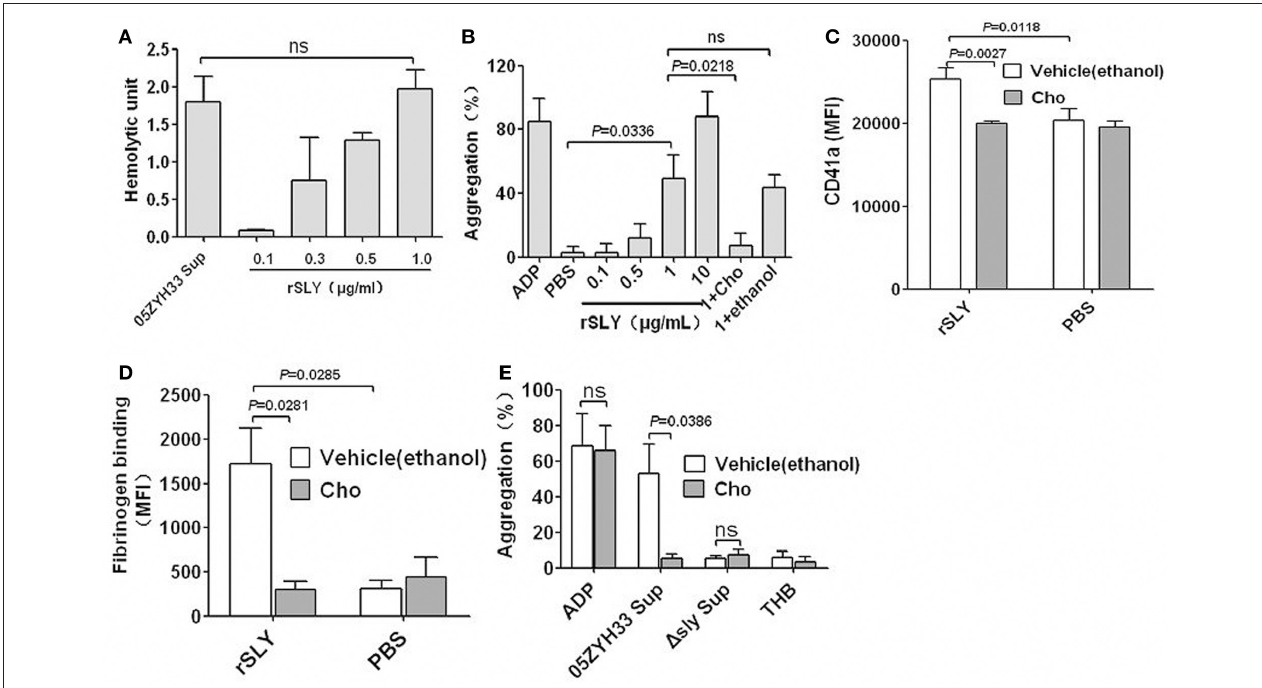
FIGURE 3 | SLY-induced platelet activation and aggregation dependent on pore formation on platelets. (A) The hemolytic activity of 05ZYH33 supernatant and rSLY. Culture supernatants of S. suis 05ZYH33 and rSLY were tested the hemolytic activity as described by Materials and Methods. One hemolytic unit is defined as the reciprocal of the suilysin titer, which was calculated as the highest dilution of the supernatant/rSLY which caused at least 50% hemolysis. (B) Dose response of rSLY-induced platelet aggregation and the cholesterol inhibiting effect. (C,D) The cholesterol inhibiting effect of rSLY-induced surface GPIIb/IIIa (CD41a) increase and fibrinogen binding to platelets in human blood were assessed by flow cytometry (Methods Section). A total of 1 µ g/ml of rSLY and 100 µ g/ml of cholesterol were used. (E) The cholesterol (100 µ g/ml) effect on S. suis supernatant-induced platelet aggregation was detected using a platelet aggregometer. Unpaired two-tailed Student’s t -test was used for (C) statistical analysis. Unpaired t -test with Welch’s correction was used for (B,D,E) statistical analysis. THB and PBS were the negative controls for culture supernatant and proteins, respectively. Cholesterol was dissolved in ethanol. rSLY, recombinant SLY; Cho, cholesterol; 1 + Cho, 1 µ g/ml of rSLY added to cholesterol. Data in panels (A–E) are expressed as the mean ± SD of three independent experiments, with each experiment using blood from a different donor. P < 0.05 is considered to be the threshold for statistical significance; ns, not significant; 05ZYH33, wild type strain; 1 sly, isogenic mutant of sly; Sup, supernatant.